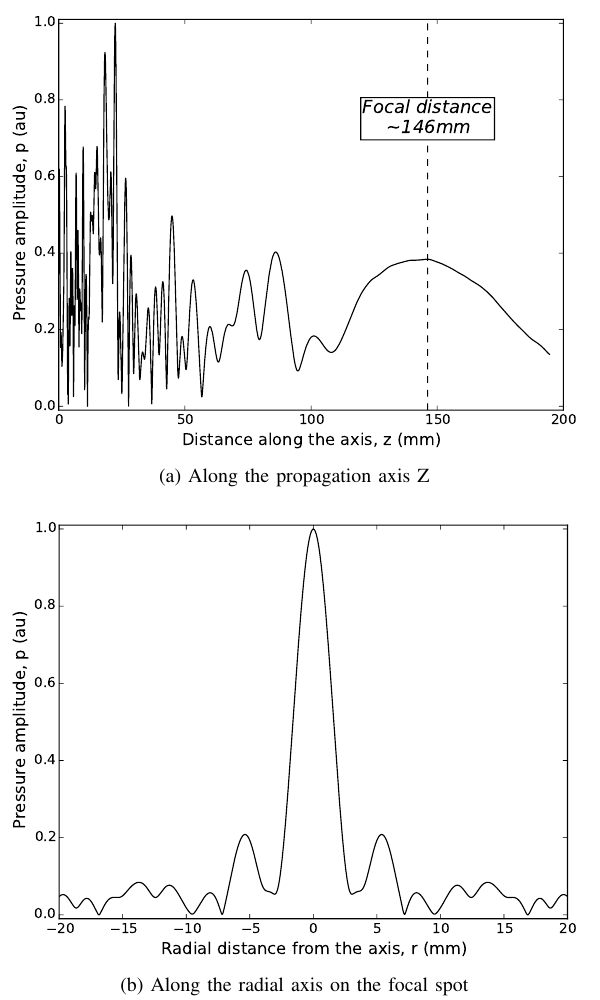
Fig. 8. Evaluation of the pressure field’s amplitude for the whole TUSHT ® configuration (2D field and evaluation axes on figure 9).